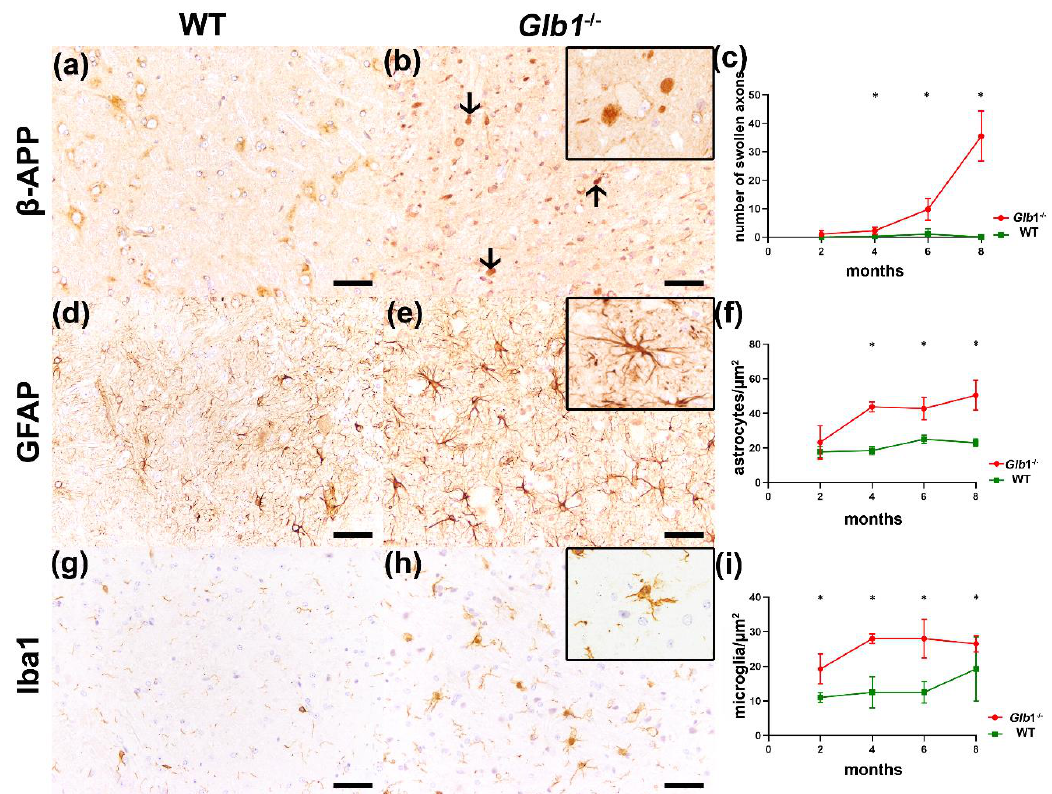
Figure 3. Axonal alterations, astrogliosis and microgliosis in Glb1 -/- mice. ( a – c ) β -APP protein in the brainstem: ( a ) Eight-month-old wildtype (WT); ( b ) eight-month-old Glb1 -/- mouse, arrows indicate β -APP positive spheroids; ( c ) quantification of β -APP positive spheroids in WT and Glb1 -/- mice from two to eight-months of age. ( d – f ) GFAP protein in the brainstem: ( d ) Eight-month-old WT; ( e ) eight-month-old Glb1 -/- mouse with an increase of GFAP positive astrocytes; ( f ) quantification of GFAP positive astrocytes in WT and Glb1 -/- mice from two to eight-months of age. ( g – i ) Iba1 protein in the brainstem: ( g ) Eight-month-old WT; ( h ) eight-month-old Glb1 -/- mouse with an increase of Iba1 positive microglia/macrophages; ( i ) quantification of Iba1 positive microglia/macrophages in WT and Glb1 -/- mice from two to eight months of age. Bars: 50 µm. red: Glb1 -/- mice, green: WT. * p < 0.05. Graphs represent mean ± SD; n = 4.